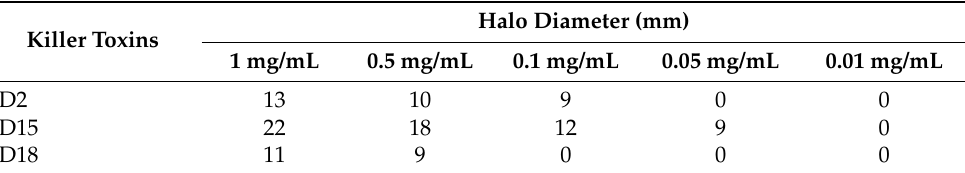
Table 2. Growth inhibition halo of sensitive Brettanomyces bruxellensis . Data represent the growth inhibition halo of the sensitive yeast strain subjected to different concentrations of each killer toxin during MIC trial.